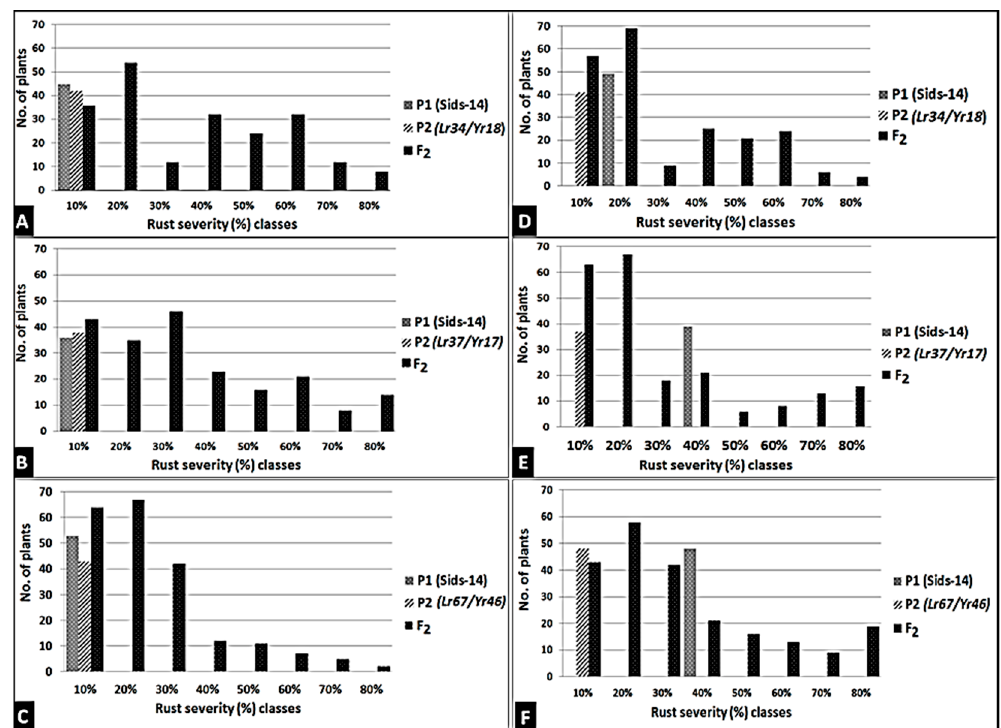
Figure 9. Frequency distribution of stripe and leaf rust severities (%) to Sids-14 × Lr34/Yr18 ( A ), Sids-14 × Lr37/Yr17 ( B ), and Sids-14 × Lr67/Yr46 ( C ) for leaf rust and Sids-14 × Lr34/Yr18 ( D ), Sids-14 × Lr37/Yr17 ( E ), and Sids-14 × Lr67/Yr46 ( F ) for stripe rust.